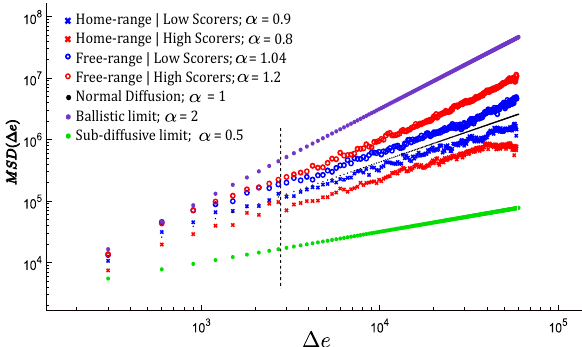
Figure 3. Mean Squared Displacement as a function of energy expended for the ensemble of trajectories in home-range and free-range conditions, separated by low (blue) and high (red) scorers. Functions are also divided into local (left) and non-local (right) scales by the vertical dashed black line, and anchors of normal diffusion and ballistic and sub-diffusive limits are shown for